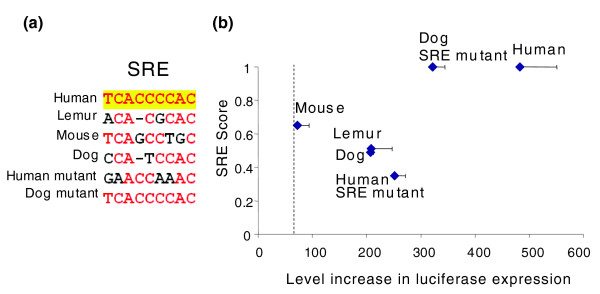
Relation between SRE motif score and response of PS2 enhancer to SREBP-2. (a) Alignment of sequences from indicated species at positions orthologous to human PS2 sterol regulatory element (SRE). 'Human mutant' refers to the mutated human SRE with four point substitutions relative to the human wild-type. 'Dog mutant' refers to the consensus SRE introduced into dog PS2 by means of three point substitutions. (b) Luciferase assay analysis of reporter construct and the SRE binding protein (SREBP)-2 expression vector cotransfection into 293T cells. The LDLR PS2 element from each of the indicated species was tested in combination with the LDLR promoter. The Y-axis denotes SRE motif score (likeness to known SRE motifs; see Materials and methods). Response of the PS2 element to SREBP-2 is shown as the increase in luciferase expression level (arbitrary units) on activation by 3 ng SREBP-2 expression vector. Expression level increase for LDLR promoter alone is indicated by the dotted line. Error bars indicate standard deviation.